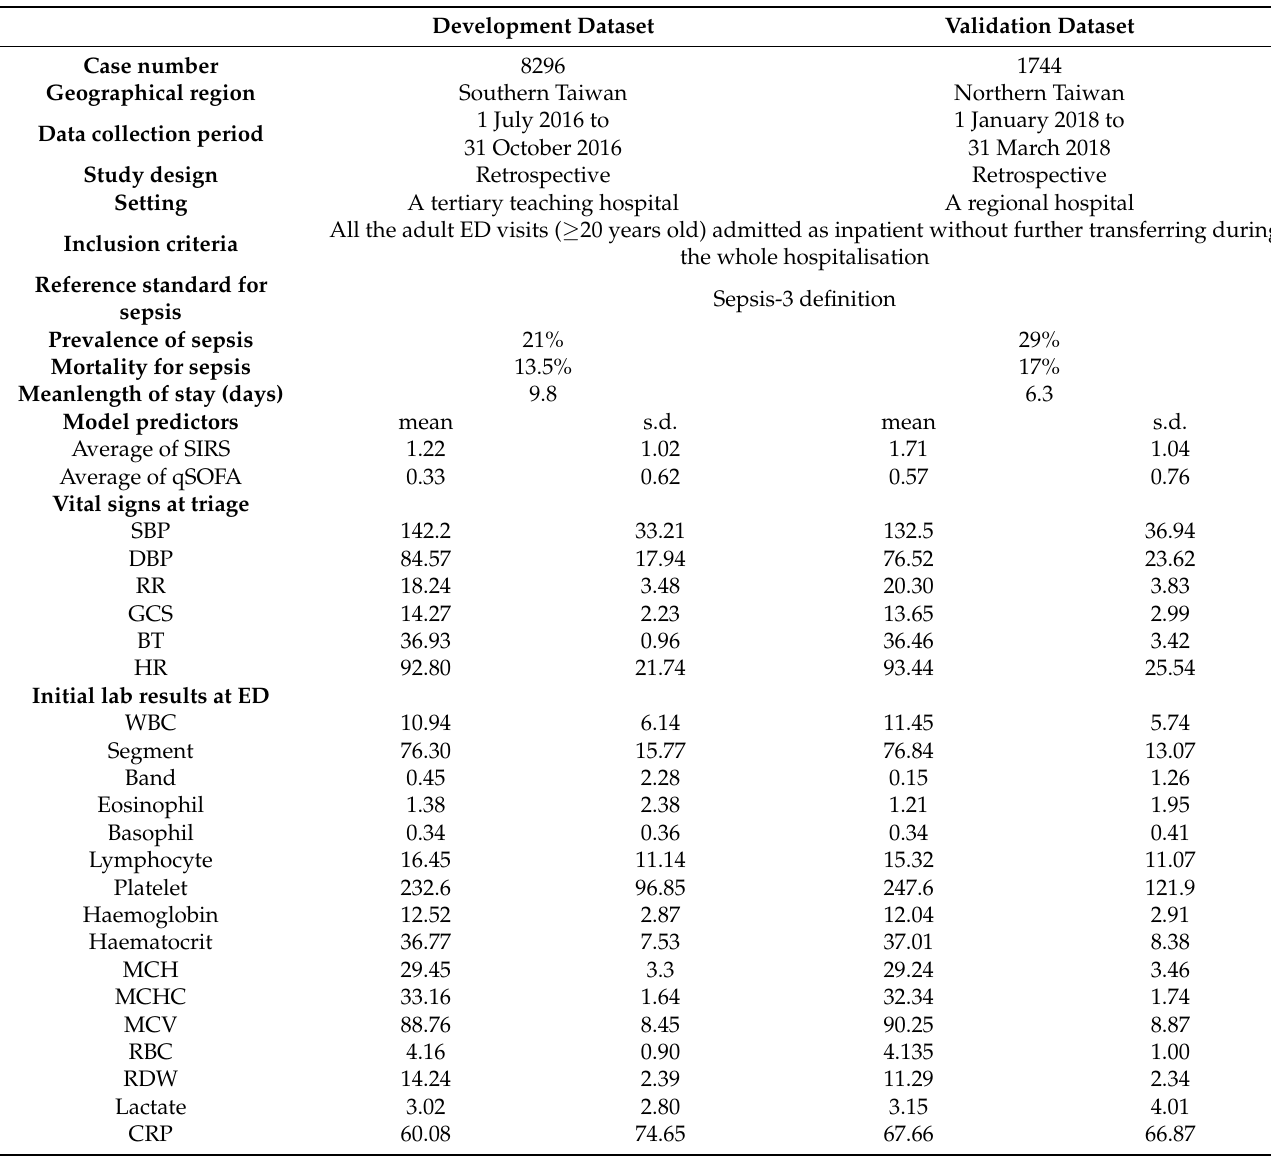
Table 2. Description of the development dataset and the external validation